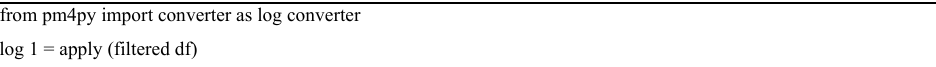
Algorithm 4. Converting into a log